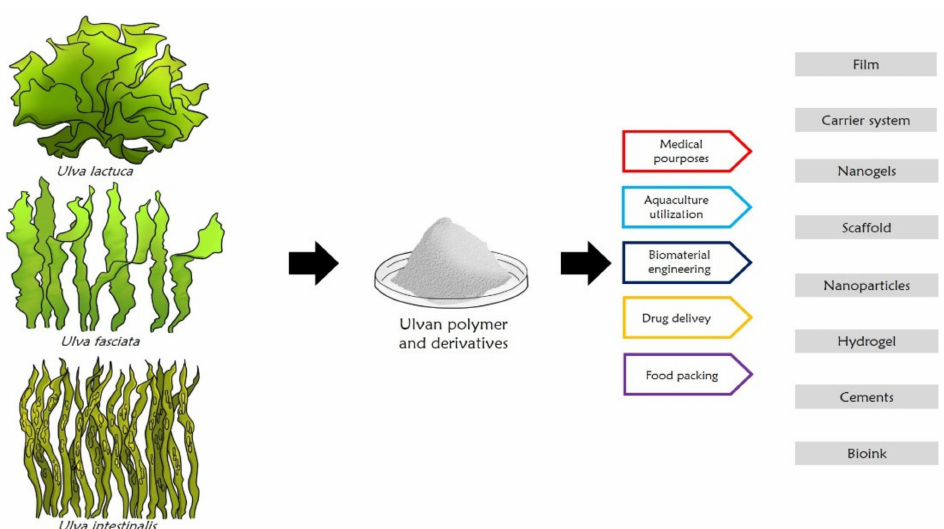
Figure 12. Schematic representation of the ulvan sources leading to different applications sectors and functional